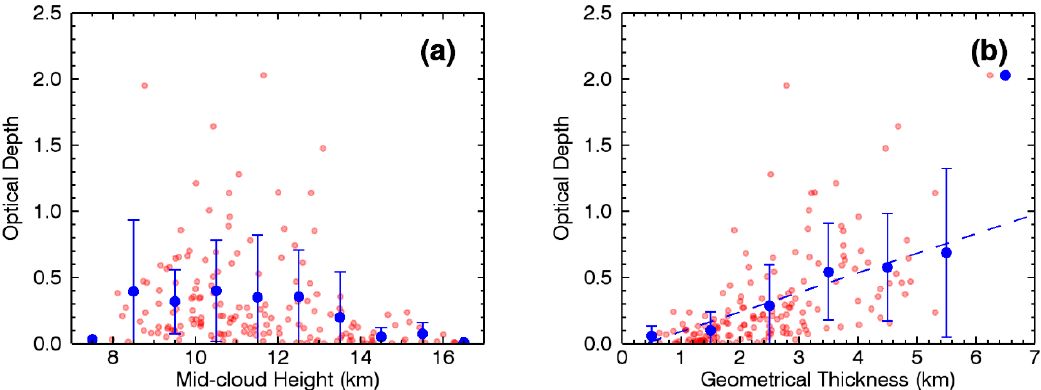
Figure 7. Scatterplots (red dots) showing the relationships between cirrus optical depth and ( a ) mid-cloud height and ( b ) geometrical thickness based on a total of 168 cirrus cloud events from one-year lidar observations at Wuhan. Blue dots and vertical bars are the associated mean values and standard deviation grouped every 1 km. Note that the cirrus optical depth tends to decrease with decreasing mid-cloud height, but increased with increasing geometrical thickness.